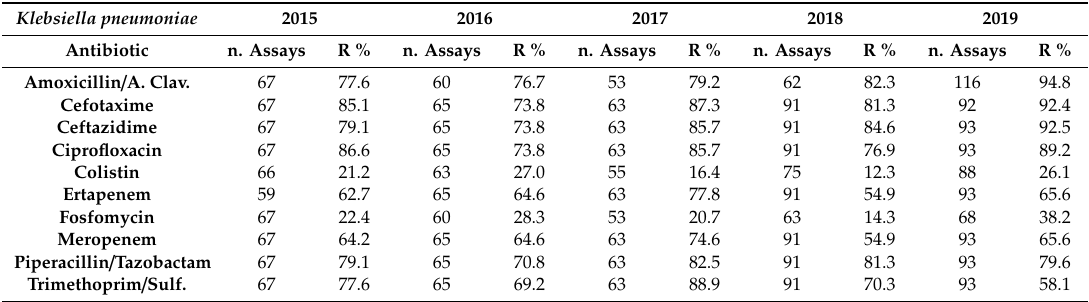
Table 4. Antimicrobial resistance profile of Klebsiella pneumoniae from patients with BSI to commonly used